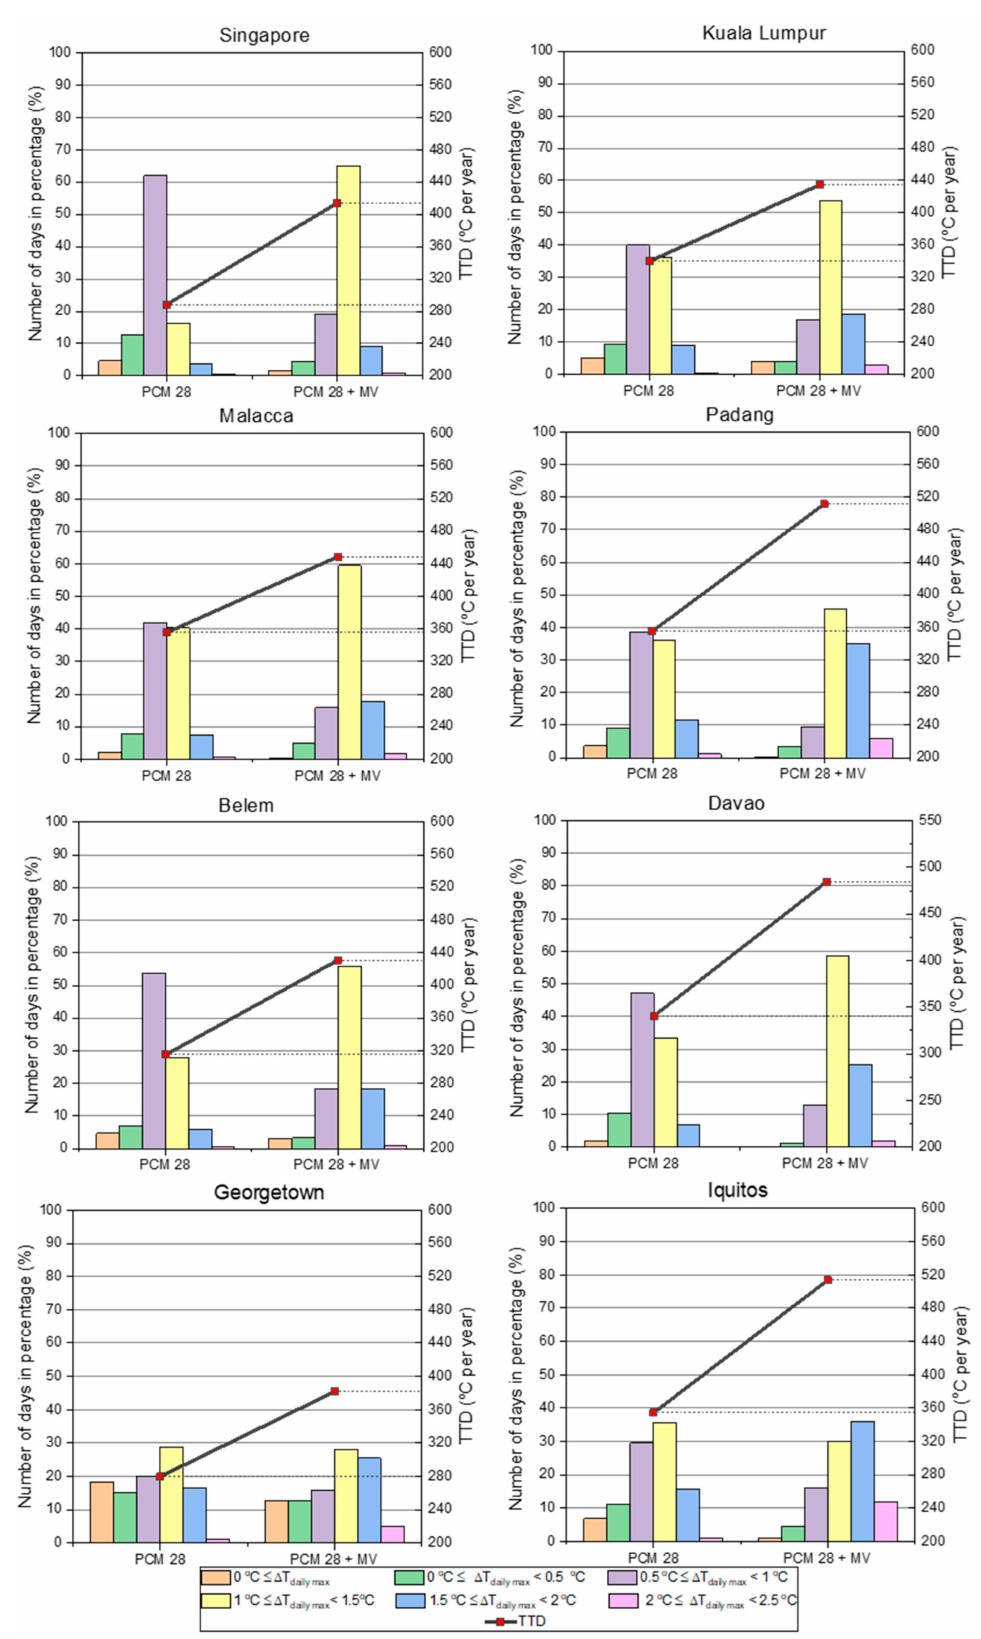
Figure 11. Maximum daily temperature drop and TTD values for all the cities integrating PCM 28 and PCM 28 +